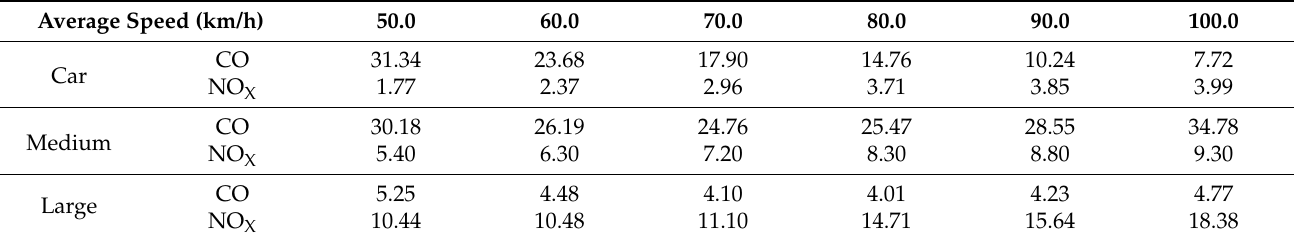
Table 4. Recommended values of vehicle emission